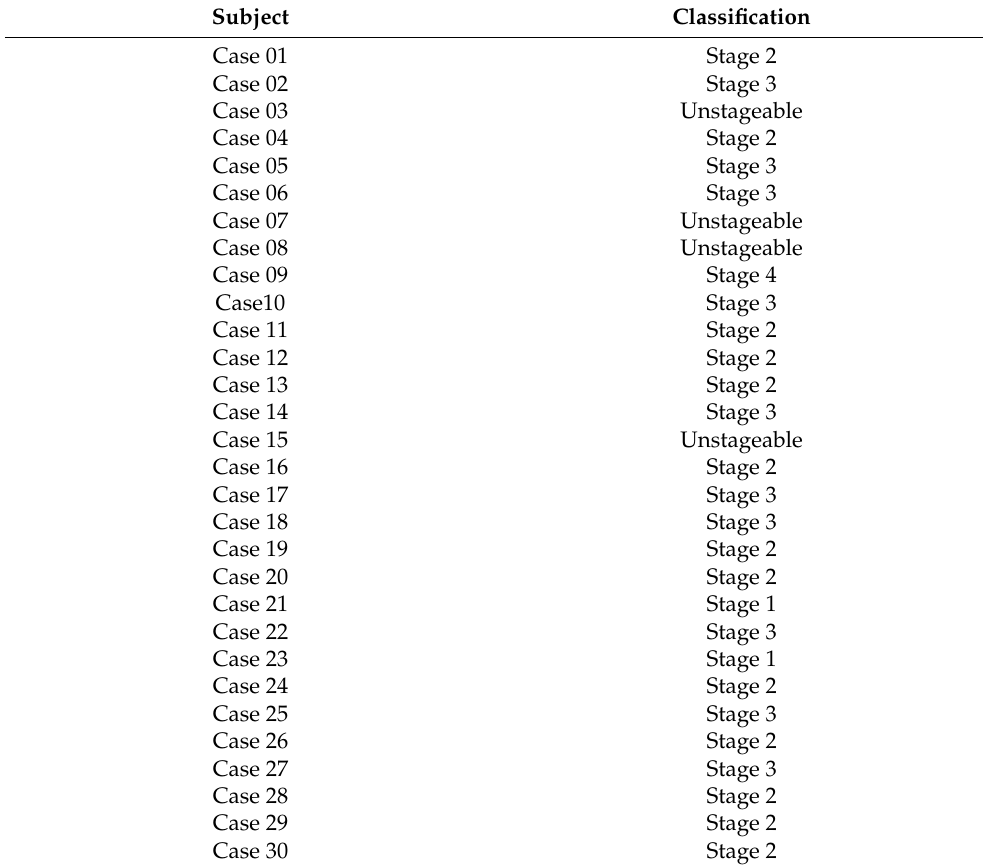
Table 2. The classifications of pressure injuries of cases judged by doctors (N =